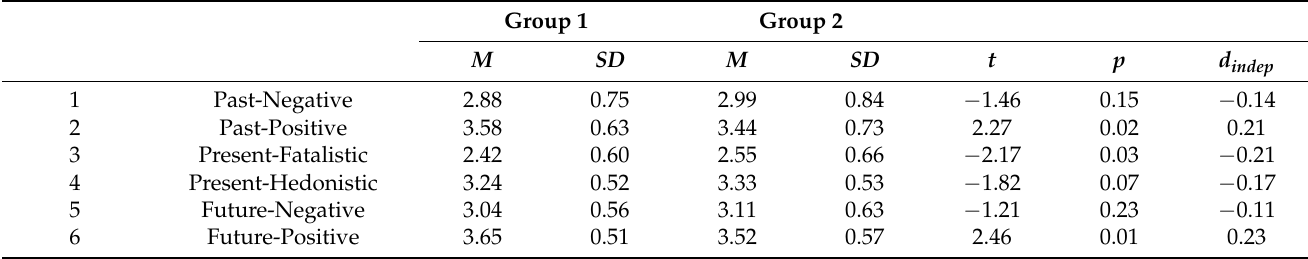
Table A2. Differences in wave 1 measurement between the participants who took part in both waves (Group 1) and those who dropped out of the study before the second measurement (Group